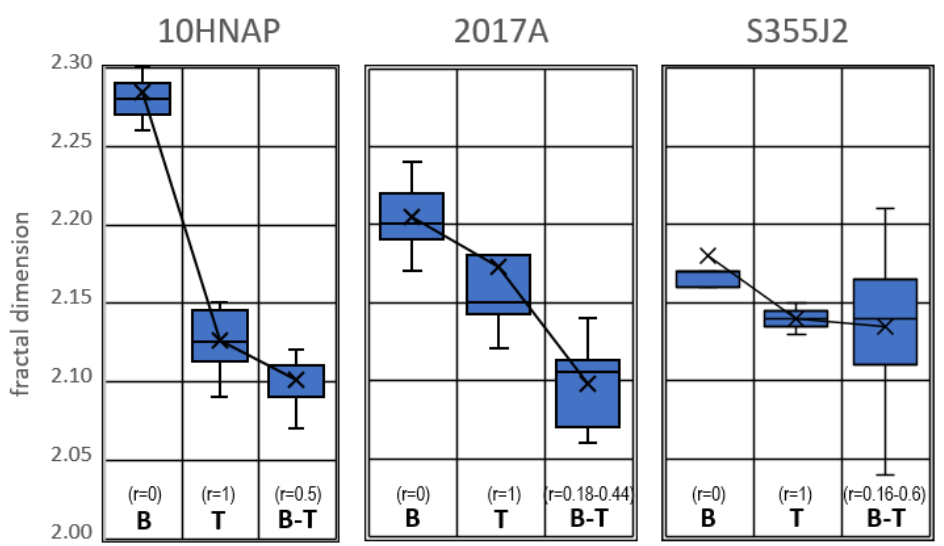
Figure 9. Fatigue fracture surface topographies averaged values for fractal dimension Df for three case by case basis loading modes (B—bending; T—torsion; B-T—bending-torsion). Adapted from [37]. The averaged fractal dimensions for bending, torsion and bending-torsion are shown in Table 3. Table 3. Averaged fractal dimension for bending (B), torsion (T) and bending-torsion (B-T).